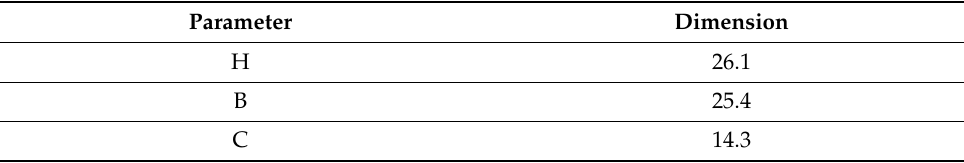
Table 1. Dimensions of the RDRA (UNIT: mm).